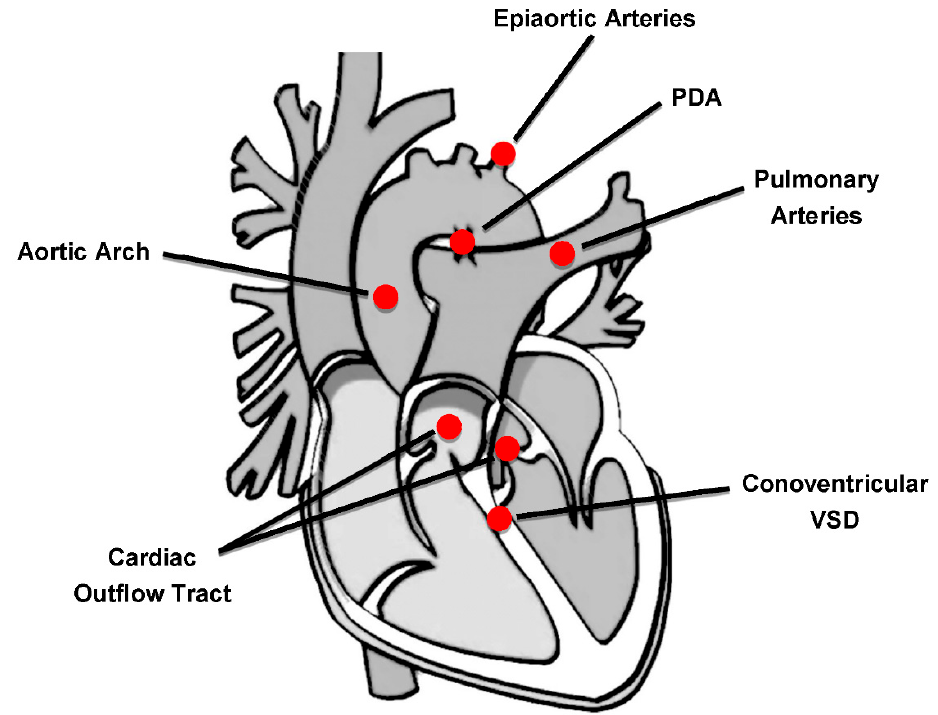
Figure 1. Cardiovascular regions involved in congenital heart defects of 22q11.2DS patients. PDA: patent ductus arteriosus; VSD: ventricular septal defect.